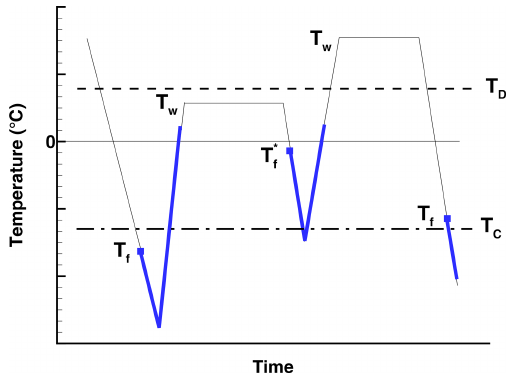
Figure 1. Schematic representation of the findings of EEZ70 defin- ing the notation used in this paper. The blue lines represent ice, and the blue squares represent points of